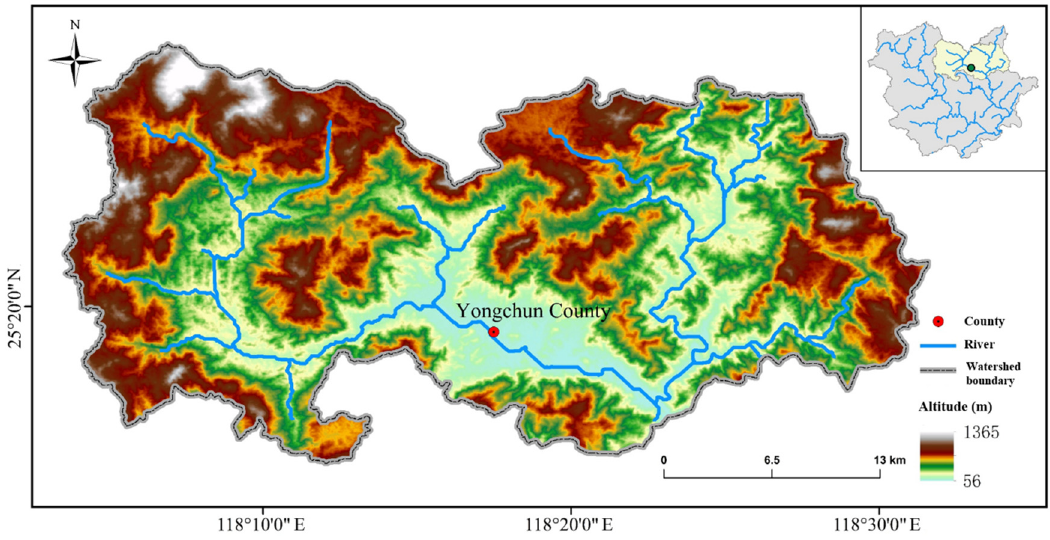
Figure 1. Location of the Taoxi Creek watershed.